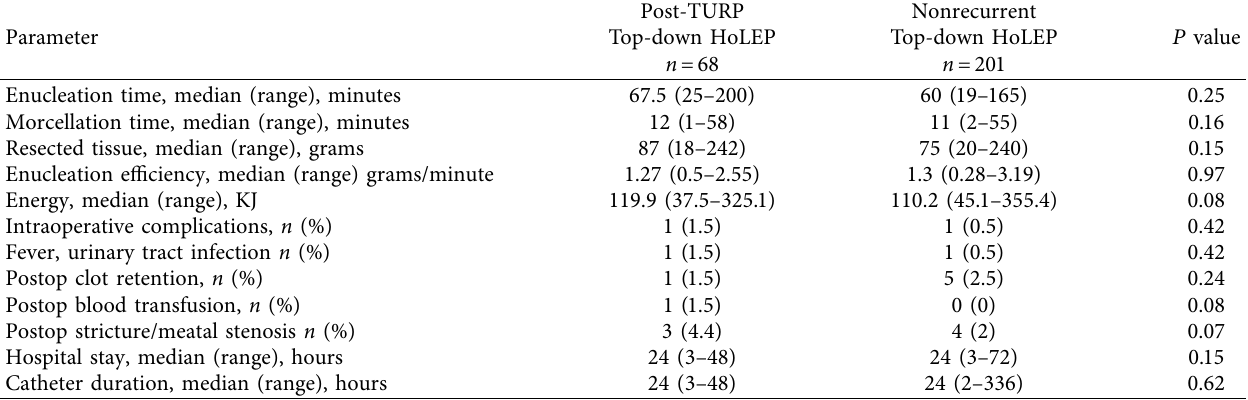
Table 2: Perioperative